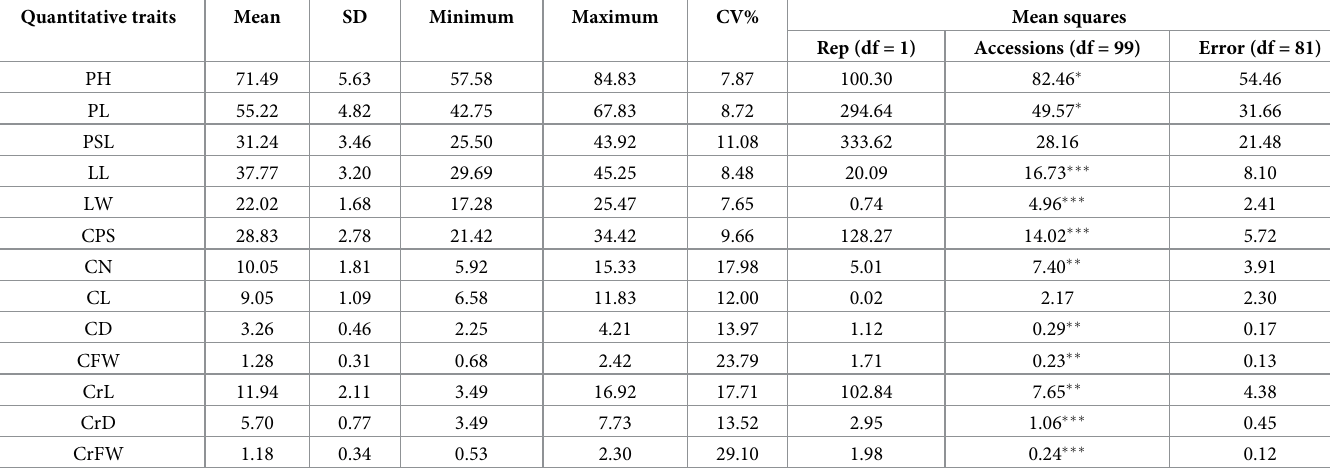
Table 2. Basic statistics and summary of mean squares of quantitative traits. Quantitative